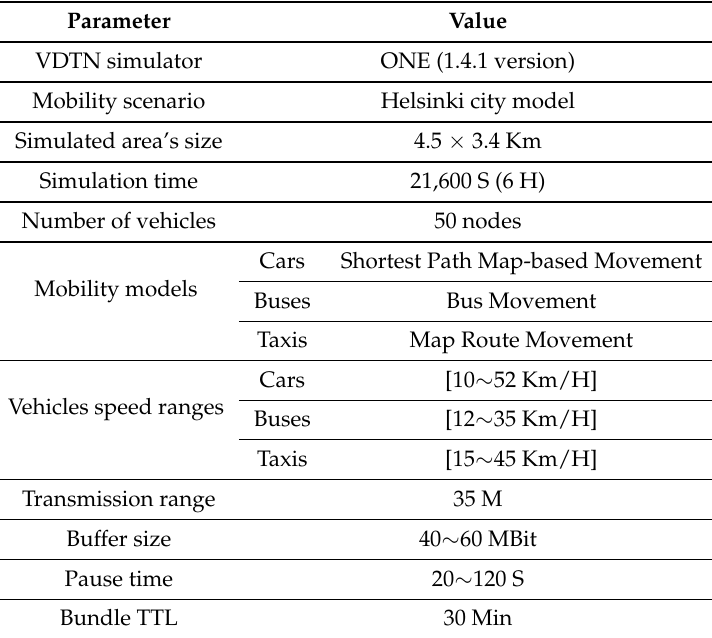
Table 3. Configuration settings of simulation tests.